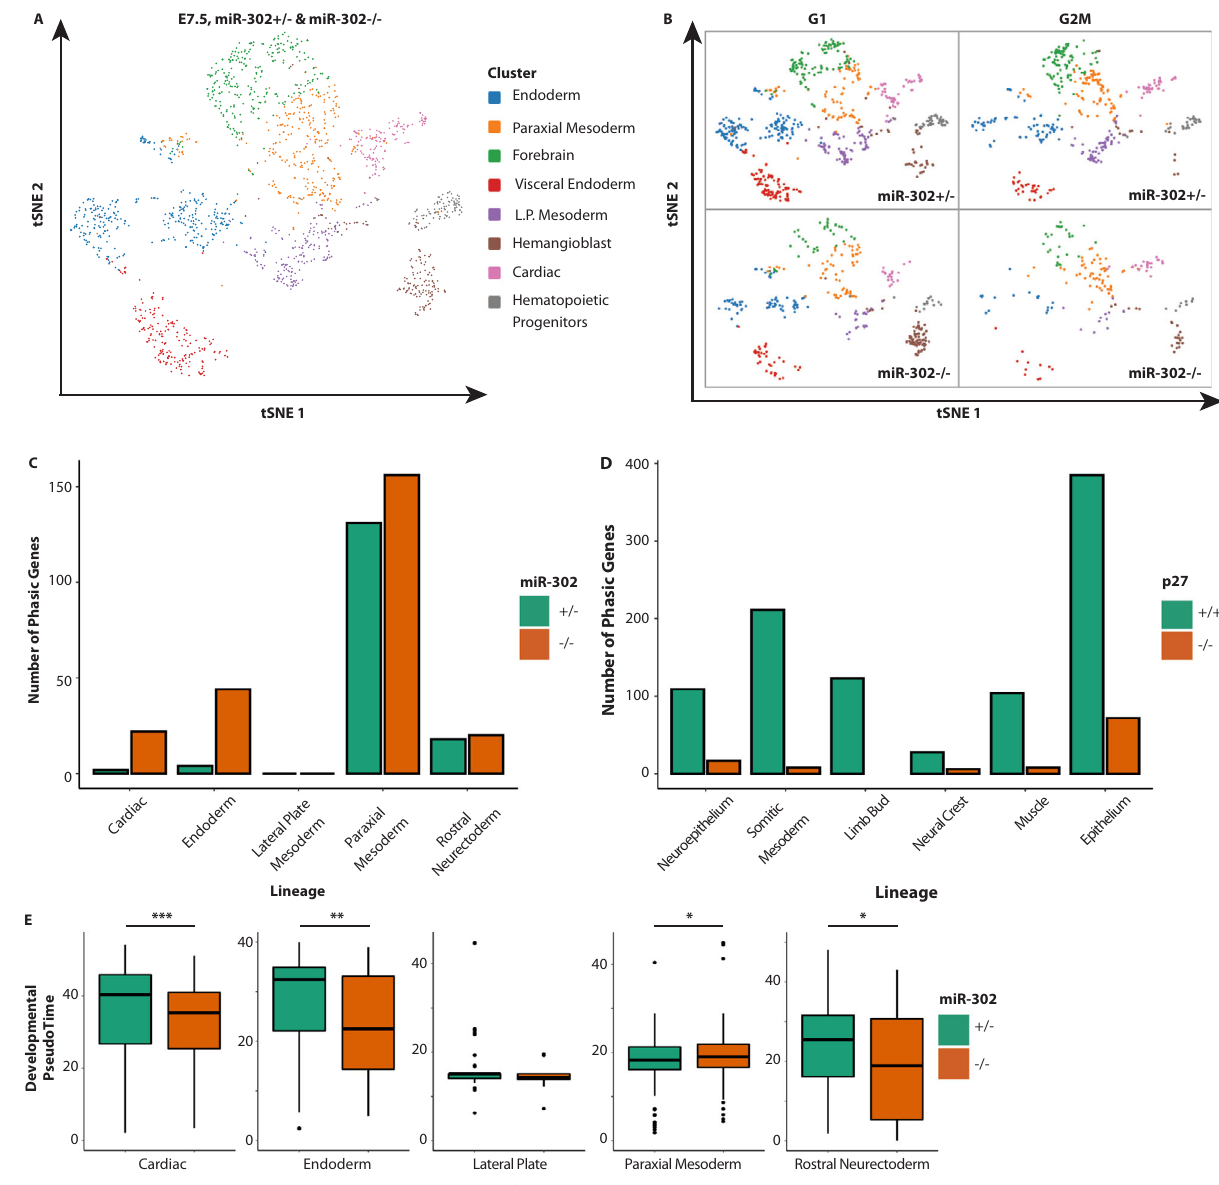
Fig. 4 mir-302 suppresses while p27 promotes phasic expression across multiple lineages. A A tSNE plot of 8 populations identi fi ed by graph-based clustering of single-cell transcriptomes of cells dissociated from whole control and mir-302 − / − E7.5 embryos ( n = 1 litter, 3 mir-302 − / − embryos and 4 mir-302 + / − embryos were pooled). B The distribution of cells from each genotype and phase within the t-SNE plot. C The number of genes showing differential expression between G1 and G2/M (median adj. P < 0.1, Hurdle model (see methods)) in each lineage of control and mir-302 − / − E7.5 embryos. Within each lineage, 100 random samples of the same number of cells from each phase were compared between the genotypes. D Same as ( C ), except for control and p27 − / − E9.5 embryos. E The distribution of pseudotime scores for individual cells within each identi fi ed lineage of control and mir-302 − / − E7.5 embryos (Cardiac *** P = 2.07e − 5 [ n = 140], Endoderm ** P = 0.0036 [ n = 315], Lateral Plate Mesoderm P = 0.21 [ n = 178], Paraxial Mesoderm * P = 0.048 [ n = 293], Rostral Neurectoderm * P = 0.012 [ n = 267], two-tailed t tests, “ n ” is the number of biologically independent cells of each type). Higher pseudotime score represents further differentiation. See Supplementary Fig. 7A for the basis of the scoring metric. Center, median. Bounds of box, 25th and 75th percentiles. Whiskers, the minima and maxima are the most extreme points within 1.5× the IQR of the box edge. The Source Data is provided in “ Source Data.xlsx ”